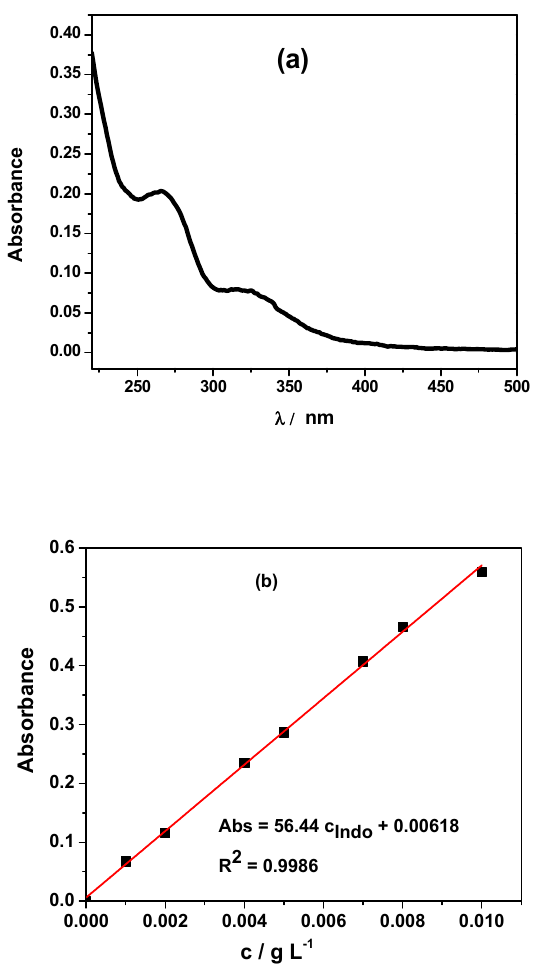
Figure 10. ( a ) UV-visible spectrum recorded for 0.01 g L − 1 (27.9 µ M) indomethacin dissolved in SBF; ( b ) calibration curve recorded in SBF for indomethacin (n = 3).